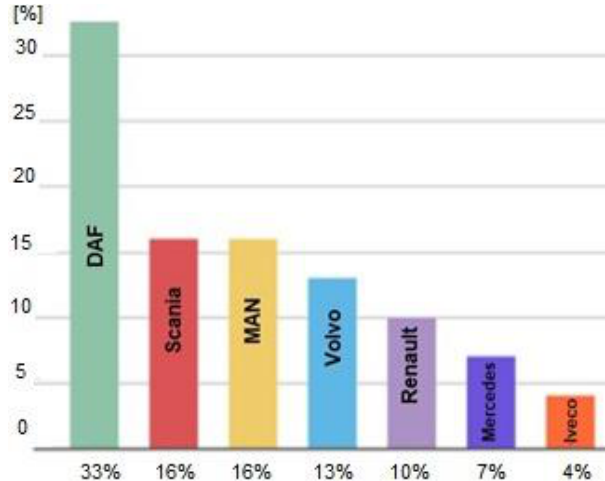
Fig. 3. The popularity of searches by brand for used tractor units [21] Reliability is an important factor in using truck. There- fore, among the used vehicles, the most popular are road trucks not older than 7 years [4, 9]. The search data for used tractor units by their year of manufacture may also indicate when selling a vehicle makes the best economic sense.